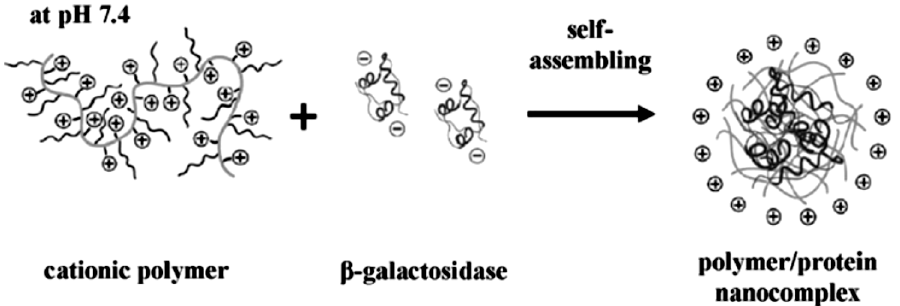
Figure 2. Schematics of the cationic polyelectrolyte in combination with the negatively charged protein ( β -galactosidase) producing hybrid protein-polymer nanostructures (reprinted with permission from